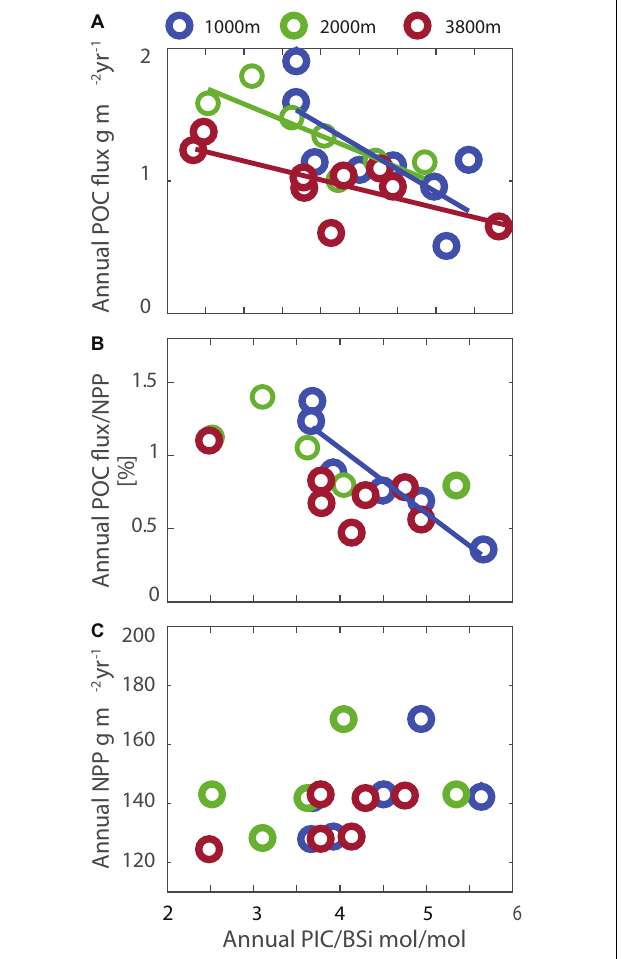
FIGURE 5 | Relationships between the two major ballasting components of sinking particles (expressed as their ratio PIC/BSi on the x -axes) and POC flux (A) , NPP (B) , and the transfer efficiency (expressed as POC flux/NPP, C ). Trend lines are shown only for statistically significant correlations.